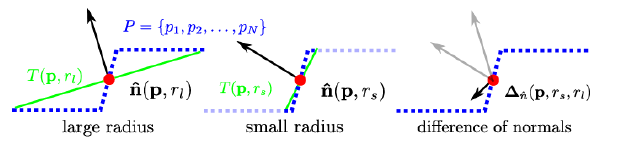
Figure 5. Difference of normals (Ioannou et al., 2012). The sign of K is an indicator of the steepness. A positive value is characterizing fat-tailed distributions whereas negative values stand for thinner-tailed ones. Symmetric distributions, e.g. nor- mal distribution, have a kurtosis with a zero value.